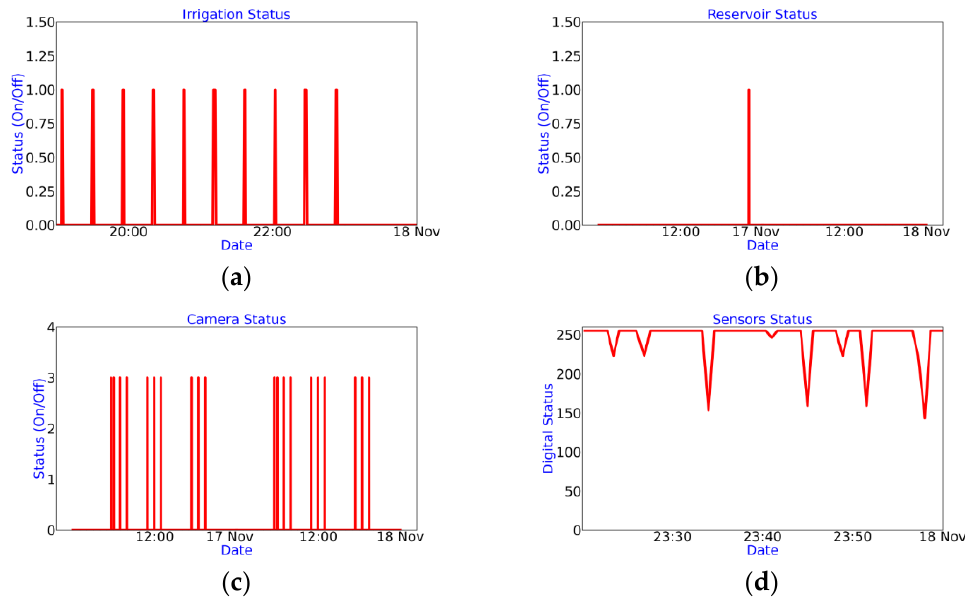
Figure 7. Status of critical microservices. ( a ) Irrigation system activation log; ( b ) recirculation system activation log; ( c ) triggers of the image acquisition system; ( d ) recording of successful measurements made by the sensors of the environmental variables channel.